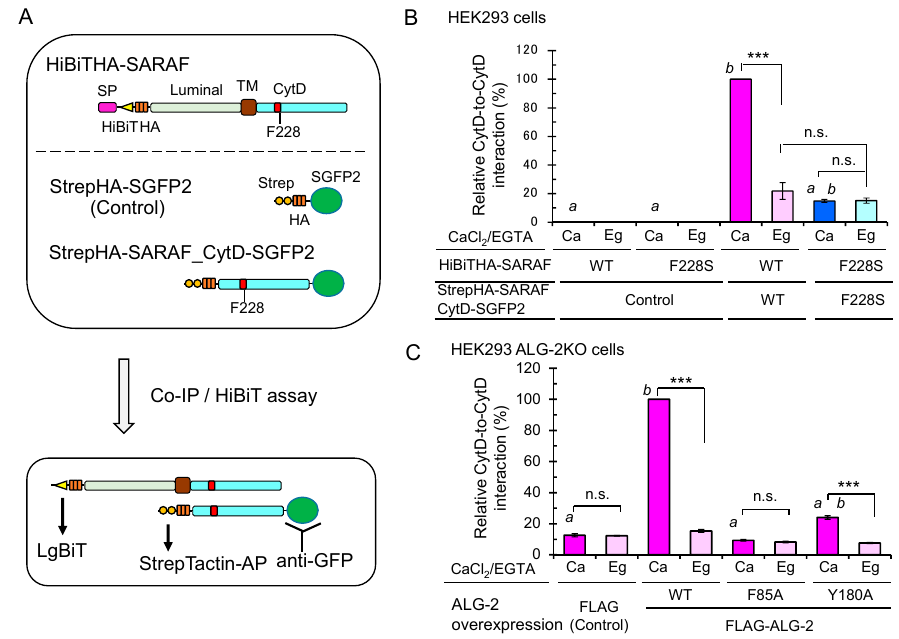
Figure 9. Importance of ALG ‐ 2 ‐ binding to SARAF for Ca 2+ ‐ dependent interaction between the SARAF CytDs. ( A ) Schematic diagram of expressed proteins and co ‐ IP/HiBiT assay. ( B ) After HEK293 cells in 6 ‐ cm dishes had been co ‐ transfected with expression plasmids for full ‐ length HiBiTHA ‐ SARAF (WT or F228S mutant) and for either StrepHA ‐ SGFP2 (Control) or StrepHA ‐ SARAF_CytD ‐ SGFP2 (WT or F228S mutant) and cultured for 24 h, the cells were lysed with lysis buffer HKM containing 1% Nonidet P ‐ 40 supplemented with protease inhibitors, 10 mM NEM and 10 μ M CaCl 2 ( Ca ) or 5 mM EGTA ( Eg ). SGFP2 ‐ fused proteins were immunoprecipitated with anti ‐ GFP pAb, and the amounts of co ‐ immunoprecipitated HiBiTHA ‐ SARAF were estimated by the lytic HiBiT assay with LgBiT. The amounts of immunoprecipitated SGFP2 ‐ fused proteins were normalized by the StrepTactin ‐ AP method as described in Materials and Methods. The relative amount of HiBiTHA ‐ SARAF WT co ‐ immunoprecipitated with StrepHA ‐ SARAF_CytD ‐ SGFP2 WT was expressed as 100% of relative interaction activity. The co ‐ IP/HiBiT assay was performed in duplicate and repeated three times. Data are expressed as mean ± SEM ( n = 3). Statistical significance by Tukey’s test is indicated in three different ways: asterisks for comparison between conditions of plus and minus Ca 2+ ; a for comparison with WT in the presence of Ca 2+ ; b for comparison with the control in the presence of Ca 2+ . p values were below 0.001 for all cases indicated (***, a , and b ). n.s., not significant. ( C ) Enhancement of the Ca 2+ ‐ dependent CytD ‐ to ‐ CytD interaction of SARAF in HEK293 ALG ‐ 2KO cells by co ‐ overexpression of FLAG ‐ ALG ‐ 2. HEK293 ALG ‐ 2KO cells were co ‐ transfected with expression plasmids for (i) full ‐ length HiBiTHA ‐ SARAF (WT), (ii) StrepHA ‐ SARAF_CytD ‐ SGFP2 (WT) and (iii) FLAG empty vector or FLAG ‐ ALG ‐ 2 (WT, F85A or Y180A) and cultured for 24 h. The cells were lysed and subjected to HiBiT assay as described above. Relative interaction by co ‐ overexpression of ALG ‐ 2 WT in the presence of Ca 2+ was expressed as 100% activity. Data are expressed as mean ± SEM ( n = 3). Statistical significance by Tukey’s test is indicated by asterisks, a , and b as described in ( B ) for comparison with the presence or absence of Ca 2+ (asterisks), WT ( a ) and control ( b ).